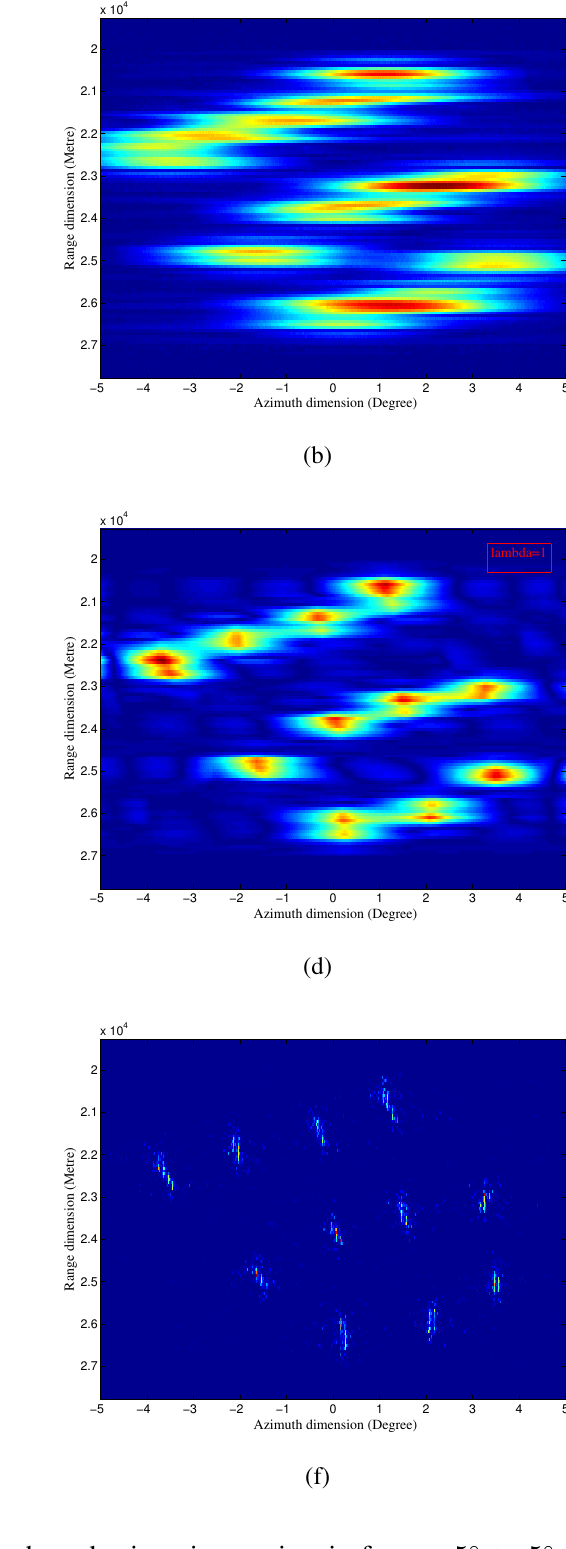
Figure 6. Simulation results of the scene when the imaging region is from − 5 ◦ to 5 ◦ . ( a ) Original scene. ( b ) Real aperture image. ( c ) RL algorithm. ( d ) Tikhonov regularization when λ = 1 . ( e ) Tikhonov regularization when λ = 5 . ( f ) Proposed MAP algorithm when q = 0 . 95